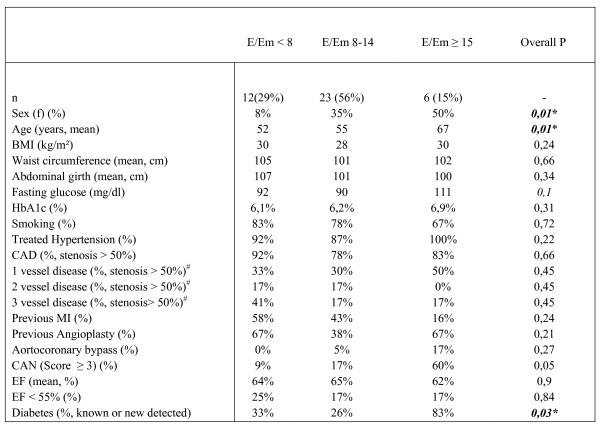
Demographics and clinical variables. Demographics and clinical variables plotted against E/Em ratio. CAN = cardiovascular autonomic neuropathy, BMI = body mass index, CAD = coronary artery disease, MI = myocardial infarction, DM = Diabetes mellitus. * = significant (P < 0,05). # = no history of aortocoronary bypass surgery.